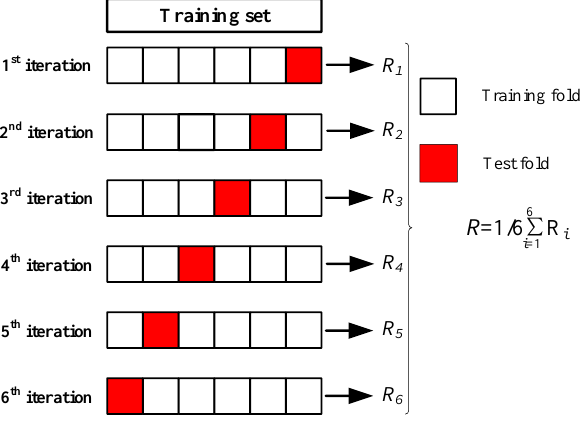
Figure 12. Schematic diagram of the 6-fold cross-validation process.